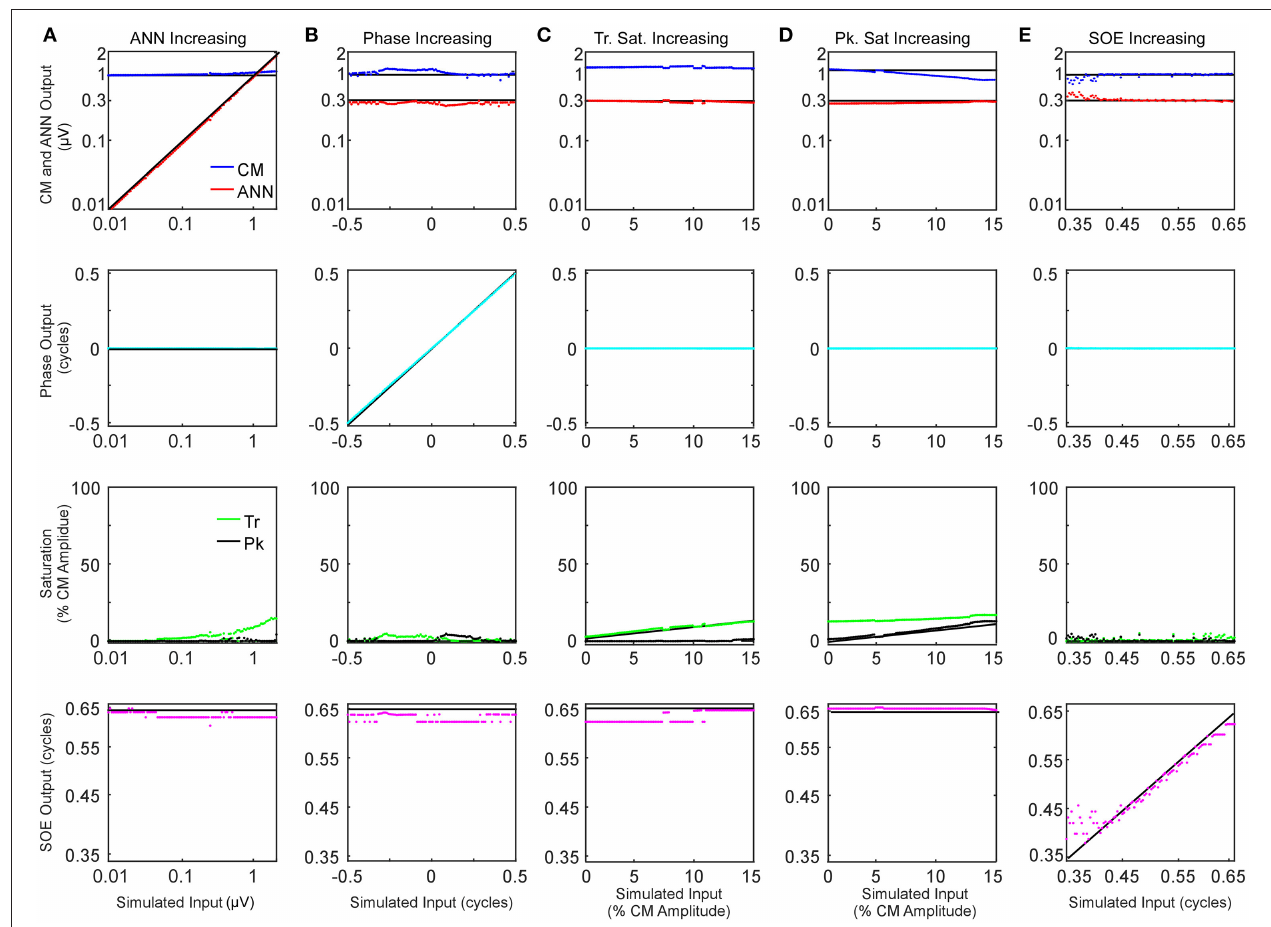
FIGURE 6 | Parametric examination of model outputs to simulated signals. The parameter varied is changed along the columns (A–E) , and the responses obtained for each parameter is varied by row. (A) The ANN amplitude was gradually increased from 0.01 to 2 µ V with CM amplitude of 1 µ V, no phase difference between the two signal components or trough or peak saturation, and SOE of 0.65 cycles. (B) The phase difference between the two CM and ANN was gradually increased from 0.5 to 0.5 cycle while CM amplitude was 1 µ V, no trough or peak saturation, and ANN amplitude was 0.3 µ V with SOE of 0.65 cycle. (C) The trough saturation of − the CM component was varied from 0 to 15% of the CM amplitude with no peak saturation, the ANN amplitude was 0.3 µ V in dB and SOE 0.65 cycles while the phase difference between the two signal components was zero. (D) The degree of peak saturation of CM was varied from zero to approximately 10% of the CM amplitude of 1 µ V while trough saturation was stable at 15% of the CM amplitude; ANN amplitude was 0.43 µ V in dB, SOE 0.65 cycles and phase difference between the two components zero. (E) The SOE increased from 0.35 to 0.65 cycles while the CM amplitude was 1 µ V, ANN amplitude was 0.3 µ V and no trough or peak saturation and the phase difference between these two signal components was